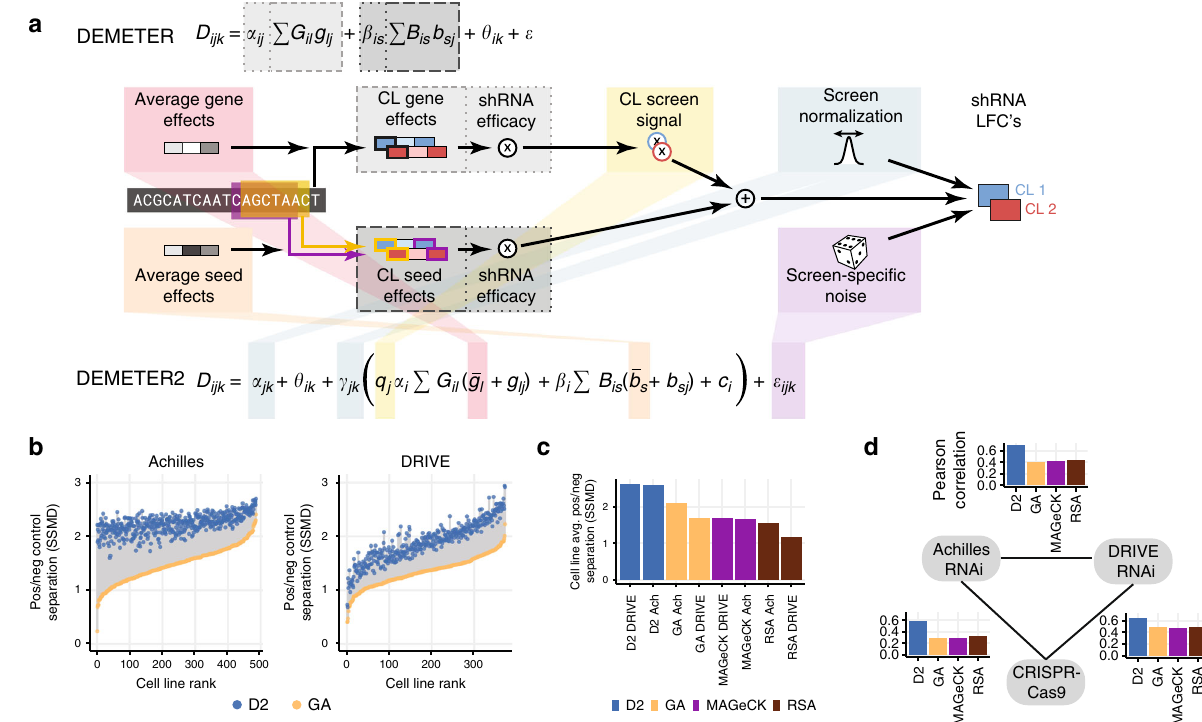
Fig. 1 DEMETER2 improves identi fi cation of essential genes. a Both D1 and D2 represent the observed shRNA log fold change (LFC) depletion values in each cell line (CL) as a combination of gene knockdown and off-target seed effects. D2 introduces a number of additional model components highlighted in the schematic diagram. b Separation of gene dependency distributions for known common essential genes and non-essential (unexpressed) genes is measured by the strictly standardized mean difference (SSMD). Positive/negative control separation was much better for DEMETER2 gene dependency scores (blue dots) compared with per-gene averaging of shRNA depletion scores (GA; yellow dots) in both the Achilles (left) and DRIVE (right) datasets. c D2 estimates of across-cell-line average gene dependency showed improved separation of positive and negative control genes compared with previous methods. d Across-cell-line average gene dependency scores were in better agreement between datasets (Achilles RNAi, DRIVE RNAi, and CRISPR-Cas9 data) when using D2 estimates compared with previous methods. Each bar chart shows the correlation of average dependency scores between a pair of datasets. Colors represent agreement when using different models for estimating dependencies from RNAi